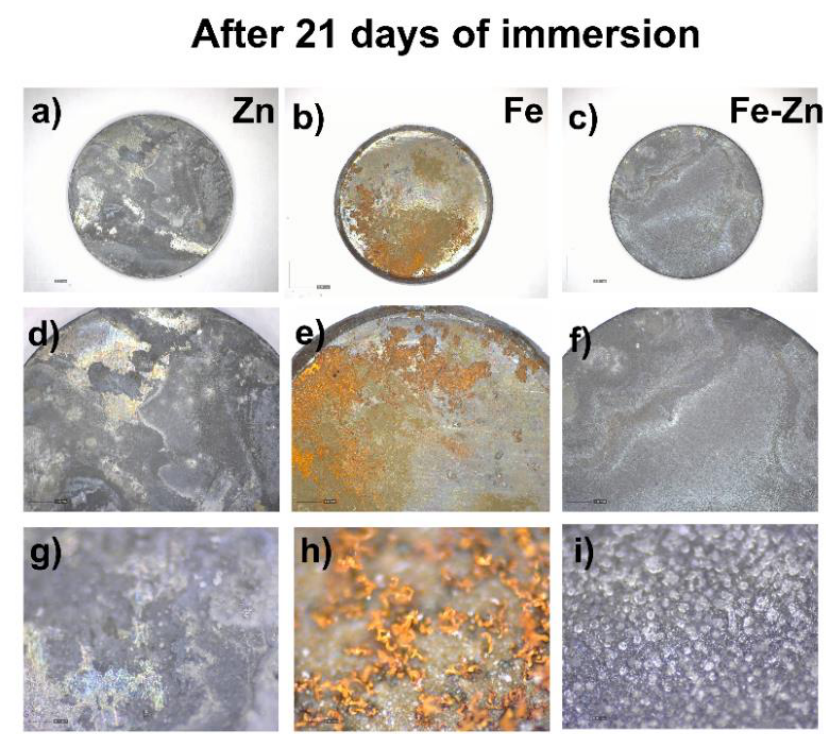
Figure 8. Optical photographs of corroded Zn ( a , d , g ), Fe ( b , e , h ) and Fe-Zn ( c , f , i ) samples after 21 days of immersion in simulated body fluids (Hanks´ solution at 37 ± 2 °C, pH = 7.4 ± 0.2).